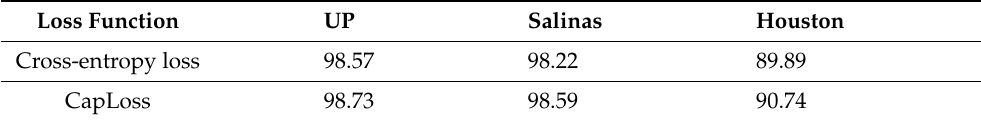
Table 6. OA(%) for AI-TFNet using cross-entropy loss or CapLoss for different datasets. Loss